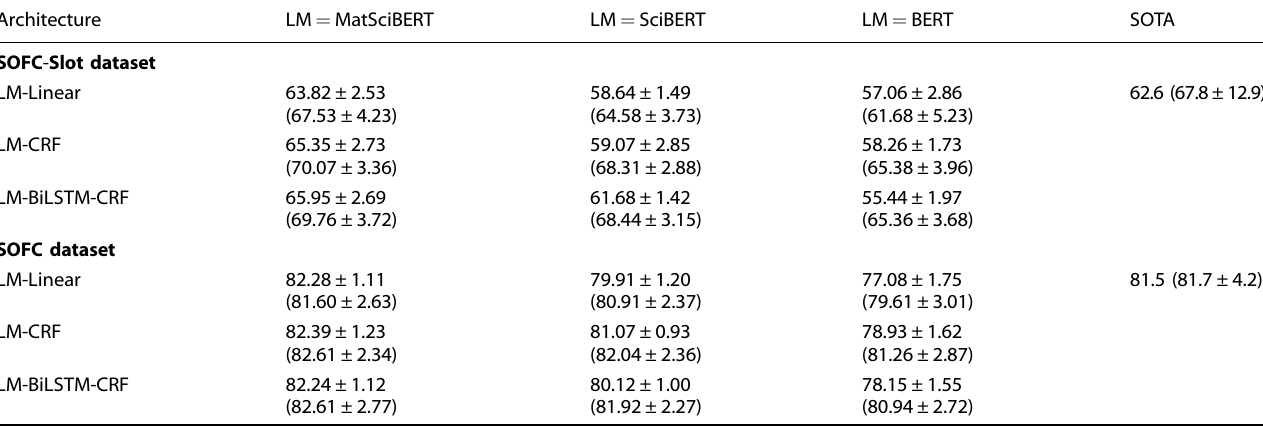
Table 1. Macro-F1 scores on the test set for SOFC-Slot and SOFC datasets averaged over three seeds and fi ve cross-validation splits.